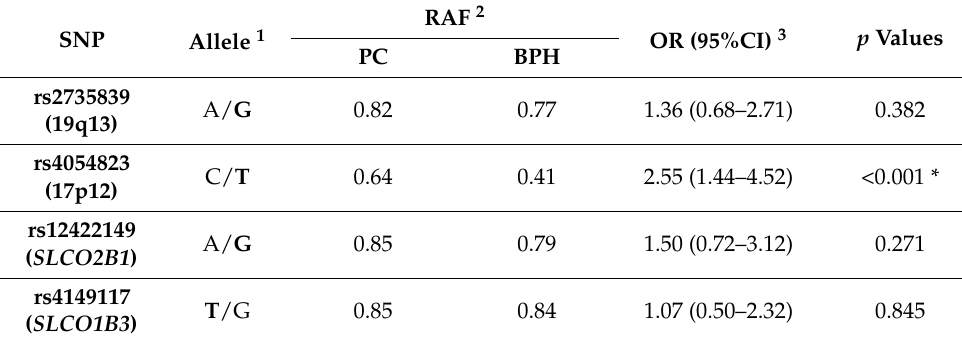
Table 3. Association between all four SNPs tested and